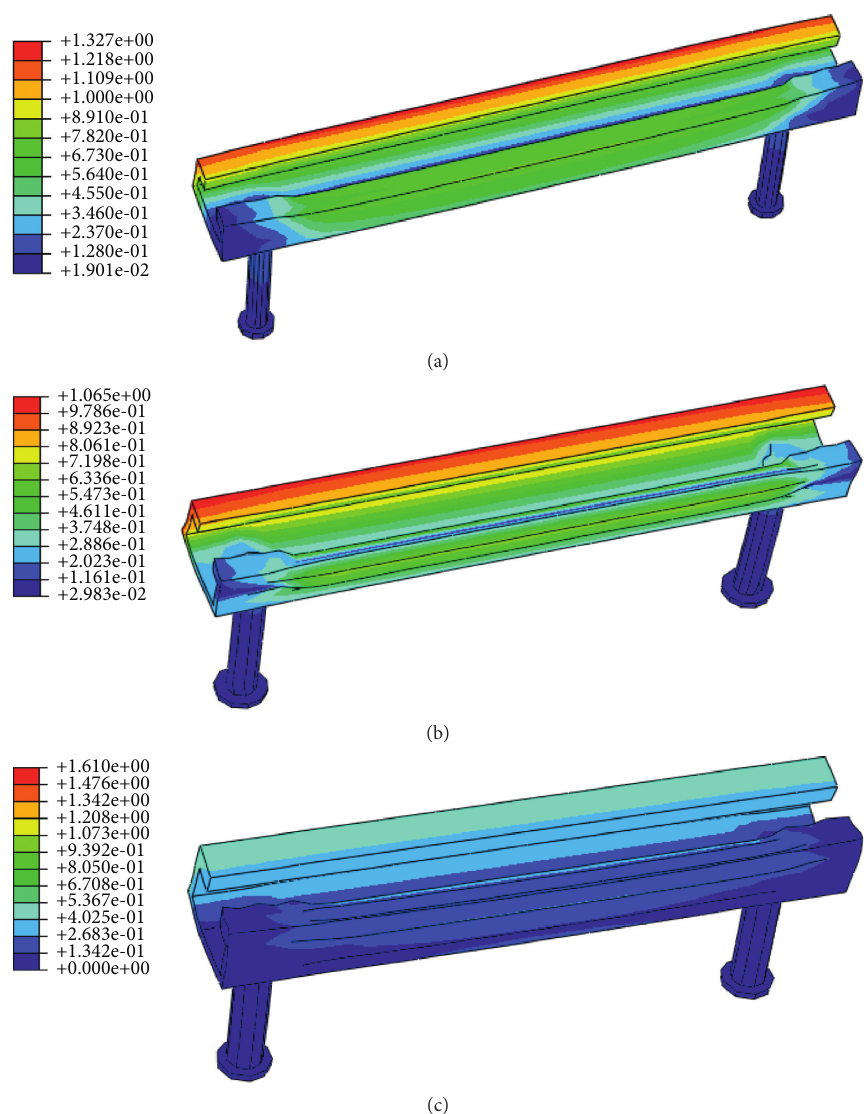
Figure 9: The embedded parts deformation diagram for (a) B-1, (b) B-2, and (c) B-3 (unit: